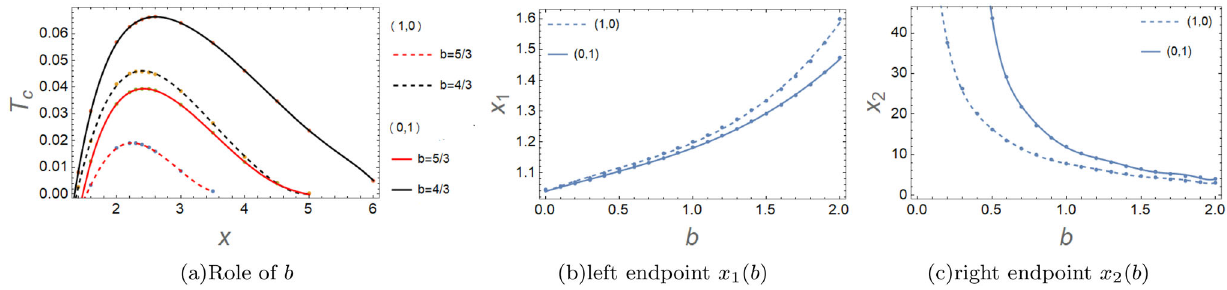
Fig. 11 a The role of b . The dome-shaped superconducting phase with the the coefficient b . Dome size increases for large Z B . b , c The left endpoint x 1 and the right endpoint x 2 . We fix a = 10 , c = 14 / 3 ,α = 0. The dashed line represents ( 1 , 0 ) , and the solid line represents ( 0 , 1 ) Fig. 12 The boundary of the pseudo-insulating phase x 0 and T 0 with the translational symmetry broken by the neutral scalars